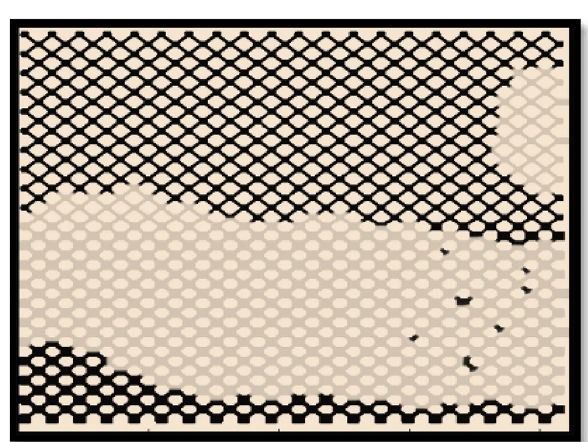
Figure 6. Modeling results for hydrogel injection.